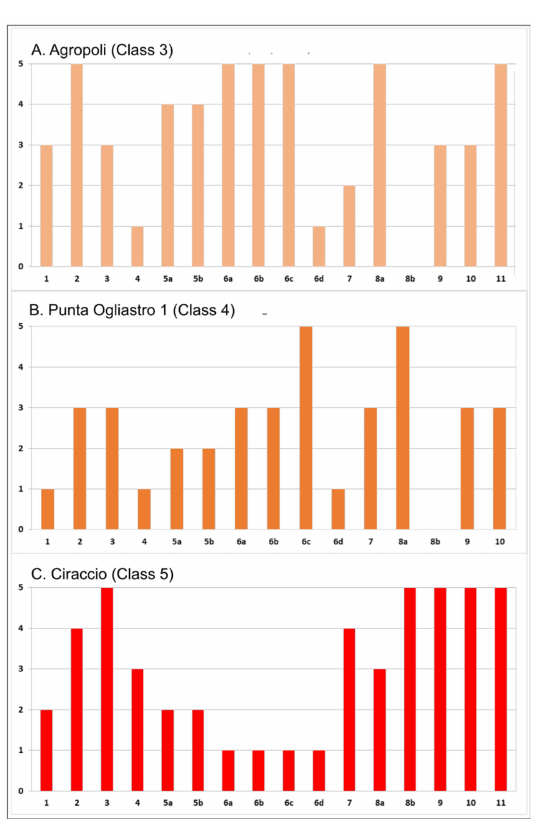
Figure A1. Graphical representations of the PEIx collected data. ( A ) Agropoli (Class 3); ( B ) Punta Ogliastro 1 (Class 4); ( C ) Ciraccio (Class 5).